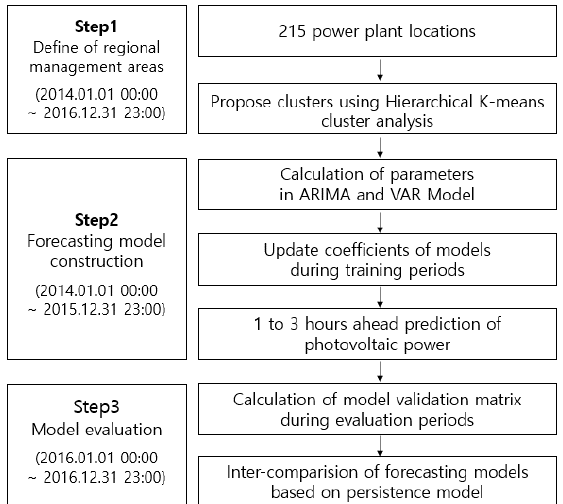
Figure 1. Schematic diagram of the photovoltaic power forecasting system based on cluster and time-series analyses.